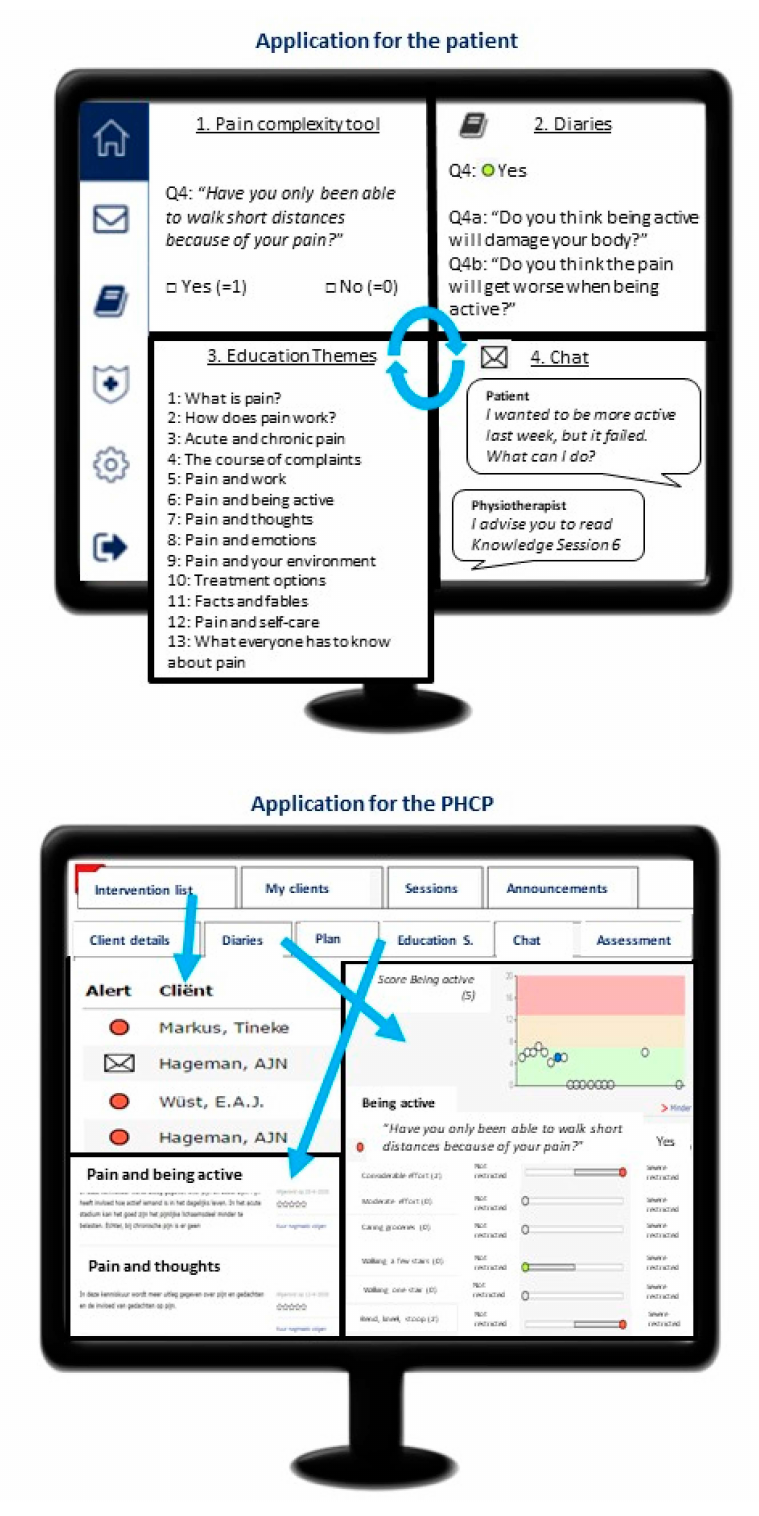
Figure 1. Content of the eCoach-Pain. At the top is the application for the patient, with the pain complexity tool, diaries, educational sessions, and chat function. At the bottom is the application for the primary healthcare professional (PHCP) with an intervention list, an overview of the diaries, and an overview of educational